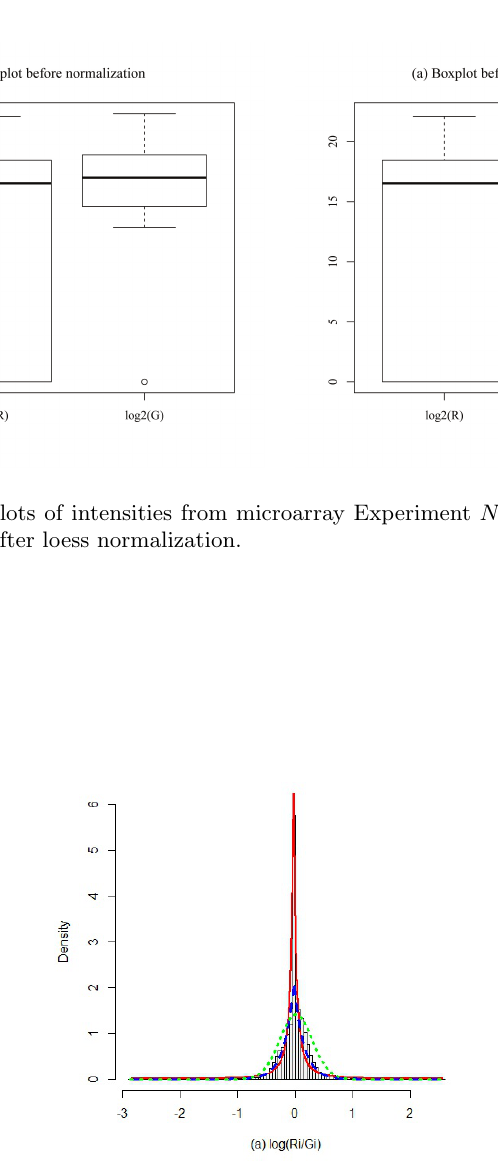
Figure 3 { Fitted double Lomax probability density function (red line), Laplace density function (blue dash) and normal density function (green dot) to the microarray gene expression